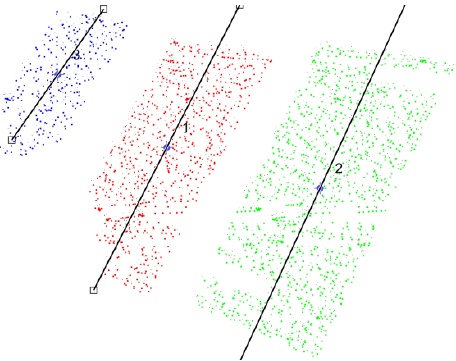
Figure 16. Principal component of each module for the first case using a down-sampling of 1:240 .